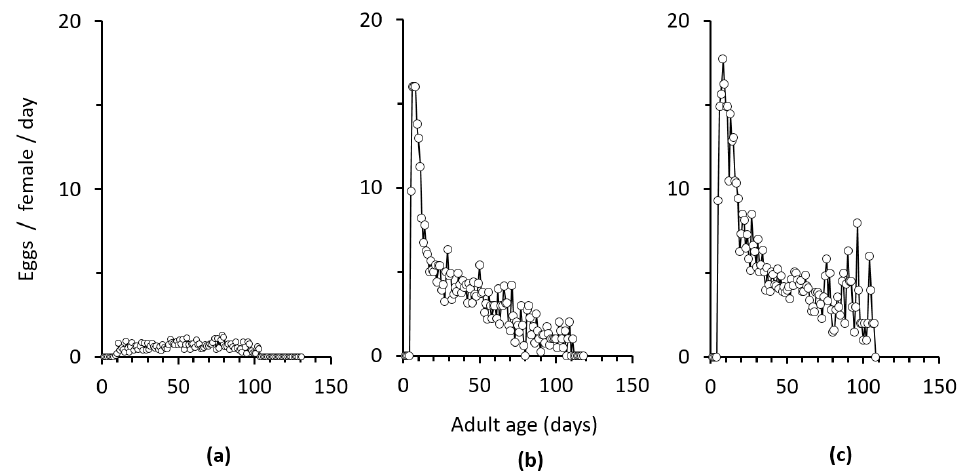
Figure 3. Mean daily oviposition of Chrysoperla agilis females depending on the duration of male availability to females for mating: ( a ) virgin females ( n = 15); ( b ) 1 week mating: the male present for 1 week ( n = 15); ( c ) lifetime: male present for the female’s lifetime ( n = 15).